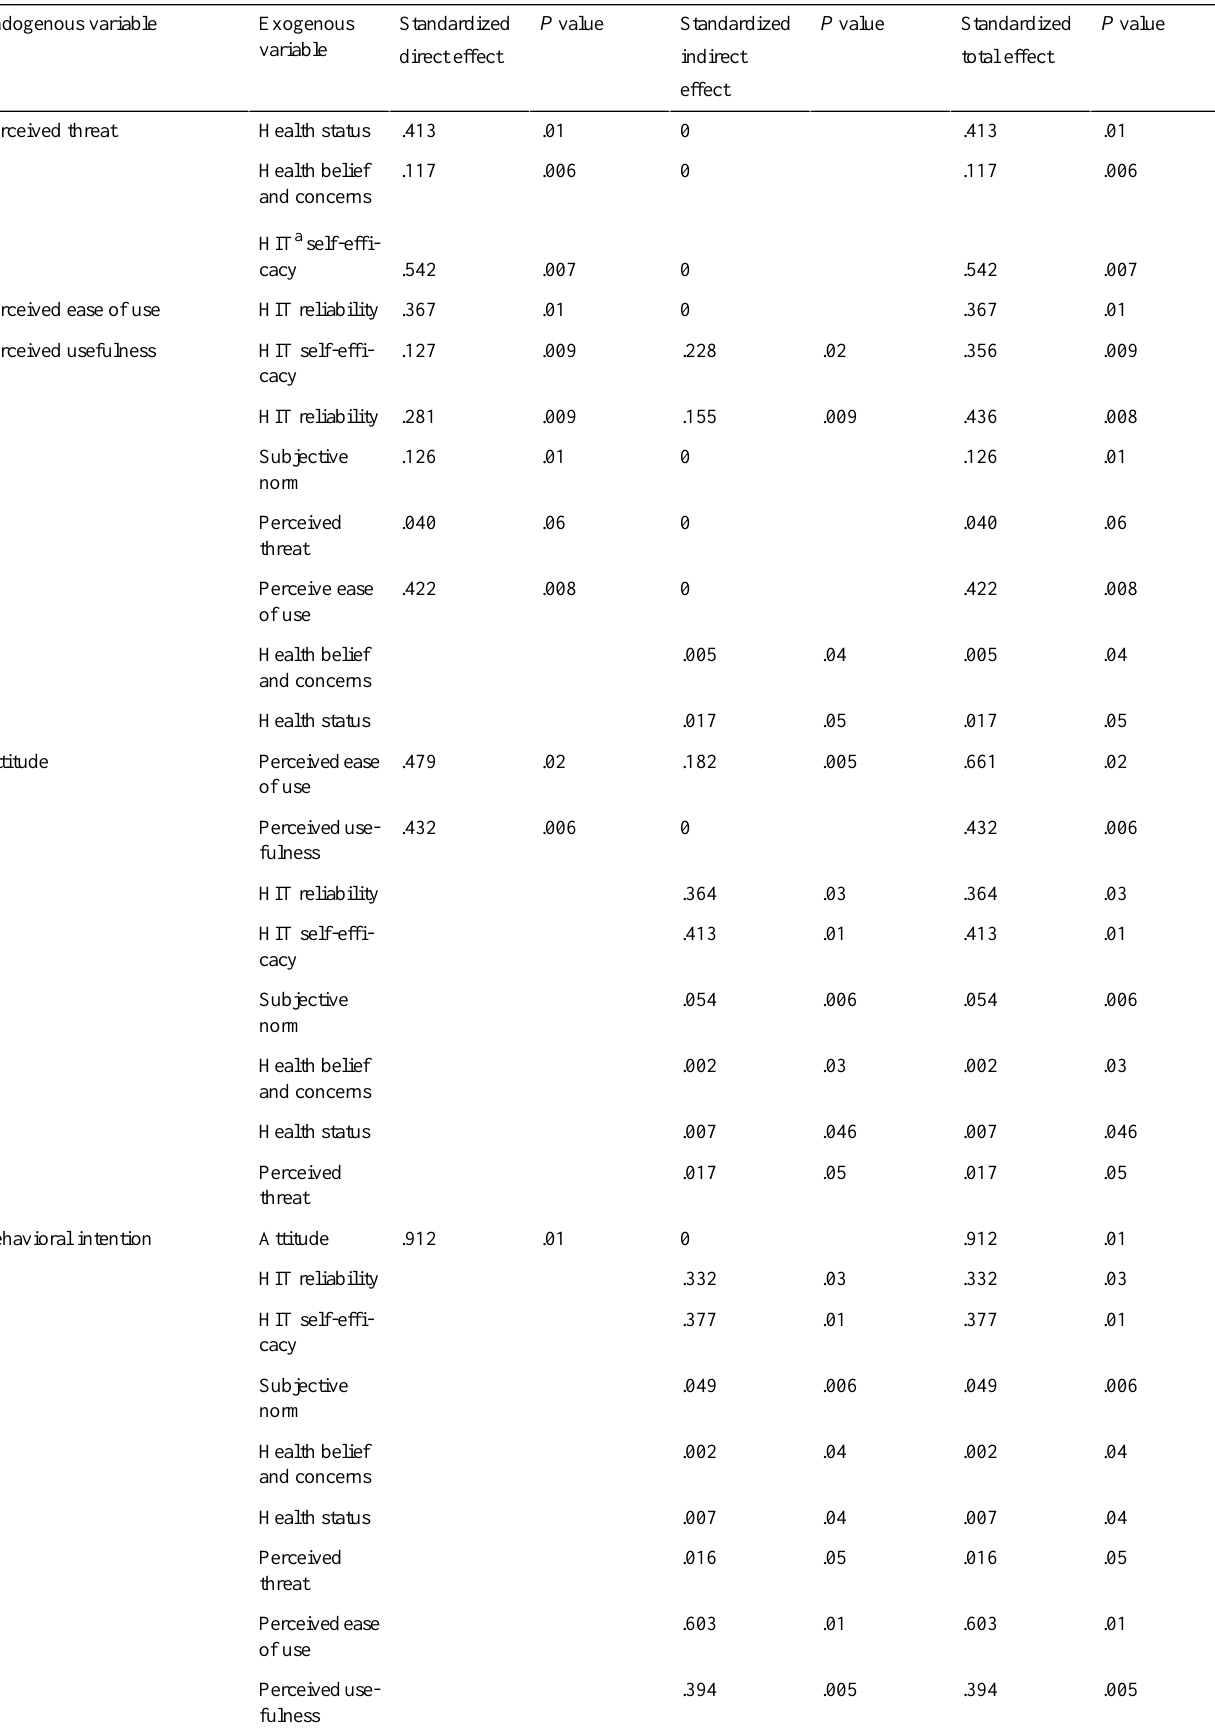
Table 6. Effects of exogenous variables on endogenous variables in the Health Information Technology Acceptance Model